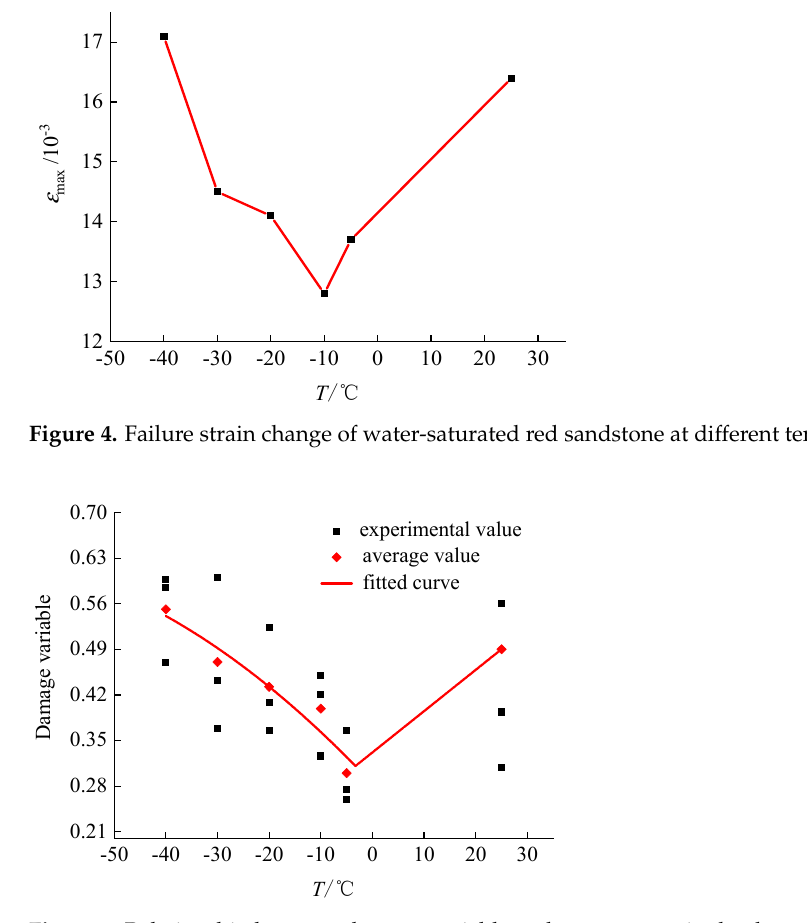
Figure 5. Relationship between damage variable and temperature in the dynamic impact